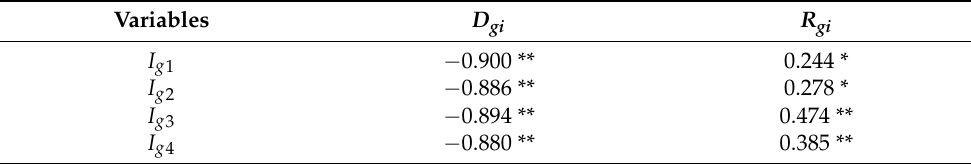
Table 5. Correlations between the intensity of mobile signaling and other variables.